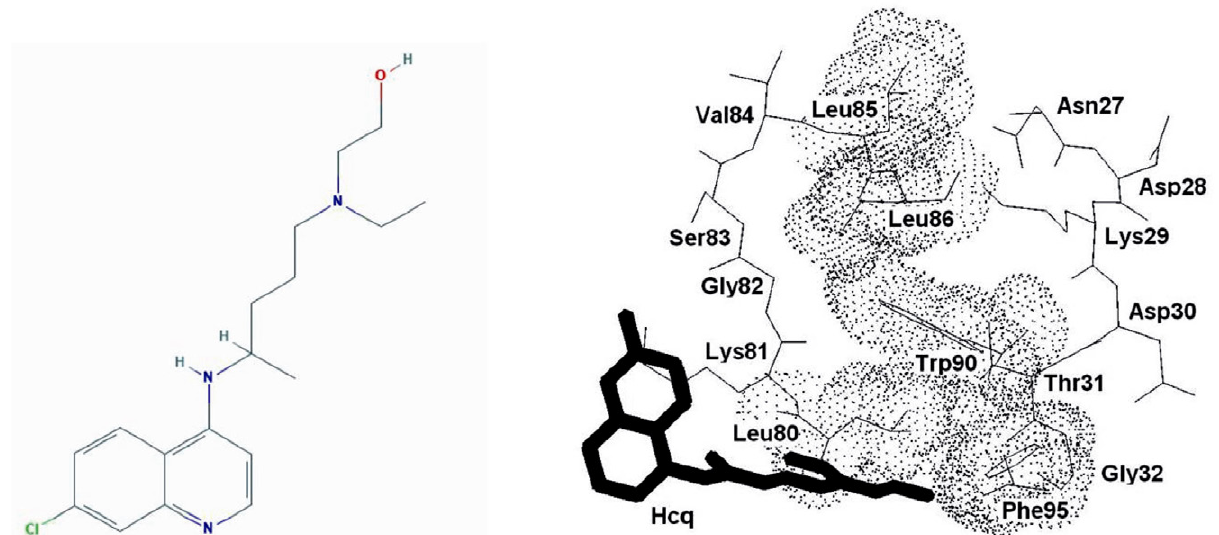
Figure 4. The chemical structure of Hidroxychloroquine (Hcq) (left). Hcq (bold sticks) that is docked in the binding site of hCoV-OC43 S (PDB ID: 6NZK). Hydrophobic interaction of the P2 (Leu80, Trp90 and Phe95) pocket (dots) with the Hcq side chain (right). No electrostatic contacts are detected.